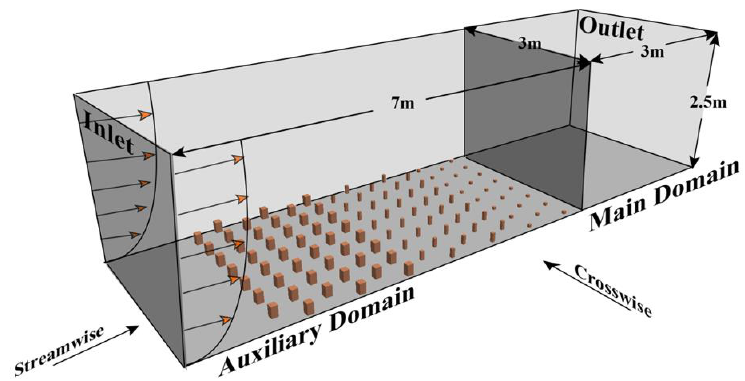
Figure 2. Domain configuration for the numerical study.